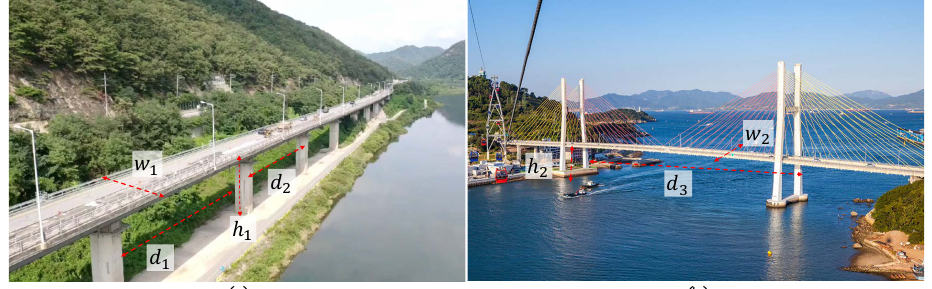
Figure 6. Experimental environments. ( a ) Deungseon Bridge (riverside bridge) and ( b ) Geobukseon Bridge (sea-crossing bridge) (( a ) d 1 : distance between the first and second columns, d 2 : distance between the second and third columns, w 1 : bottom width of the bridge, h 1 : height of each column; ( b ) d 3 : distance between main columns, h 2 : height of each column, w 2 : bottom width of the